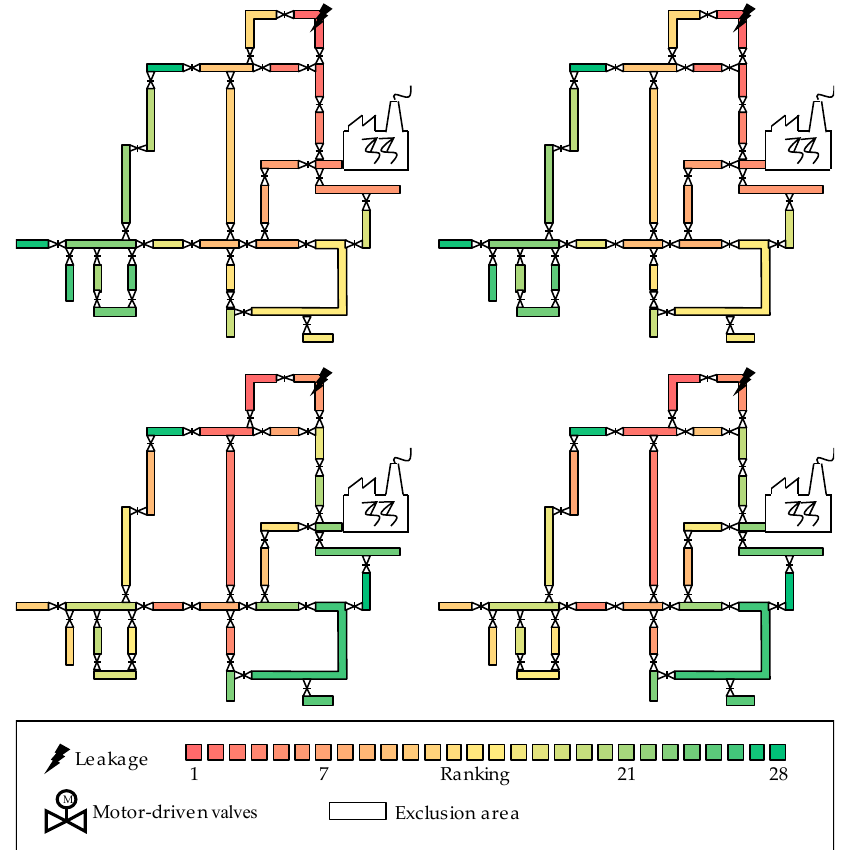
Figure 8. Result of leakage localization with MoFoDatEv with coloring of exclusion areas according to the ranking ( top left : artificial data and perfect start values for optimization; top right : artificial data and search for start values for optimization; bottom left : measurement data and perfect start values for optimization; bottom right : measurement data and search of start values for optimization).